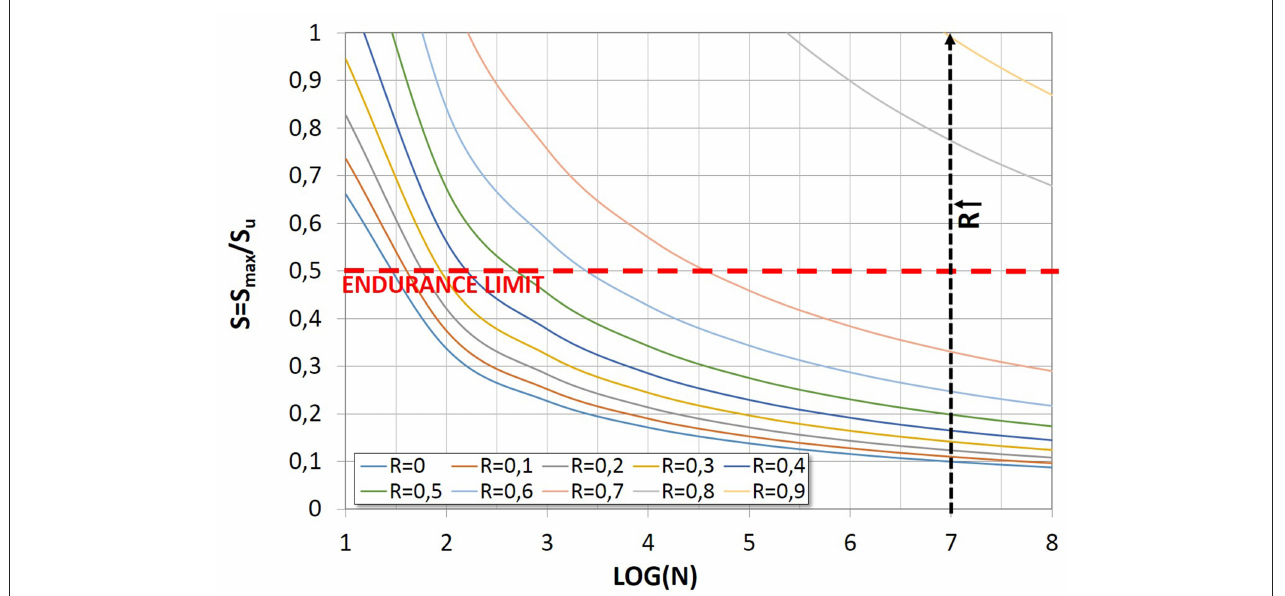
FIGURE 4 | Koltsida et al. (2018a) fatigue curves, referred to a 5% of failure